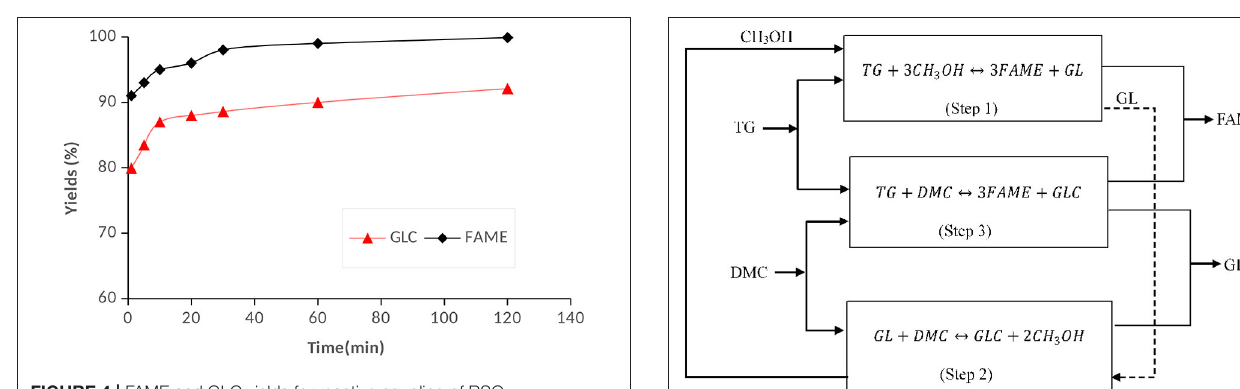
FIGURE 4 | FAME and GLC yields for reactive coupling of RSO transesterification with 2:1 methanol to RSO molar ratio, 3:1 DMC to RSO molar ratio, 60 ◦ C reaction temperature, and 5 wt% TBD guanidine. FIGURE 5 | Proposed reaction scheme for triglyceride transesterification with